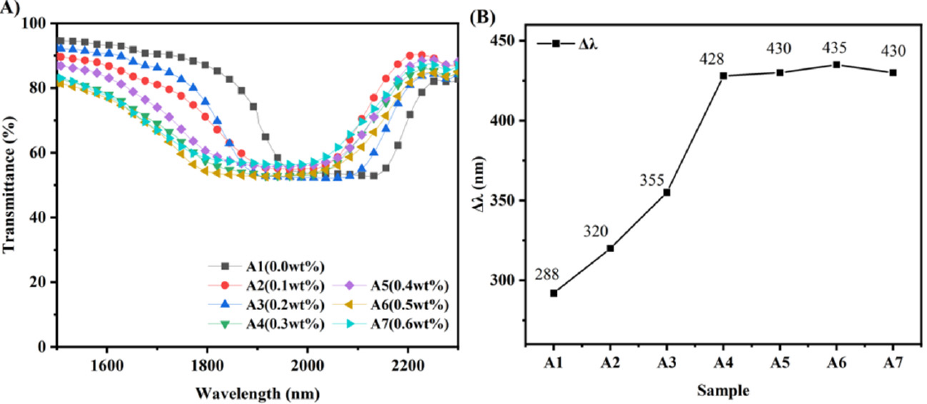
∆ λ of samples A1–A7 ( B